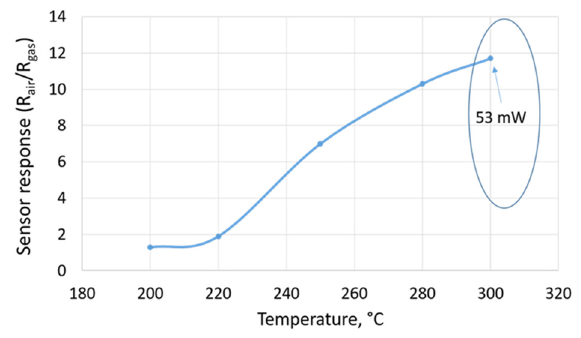
Figure 8 . The response of the sensor as a function of a heater temperature.